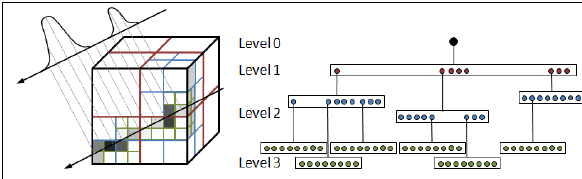
Figure 6. Principle of ray tracing (left) and corresponding generalised octree structure (right)